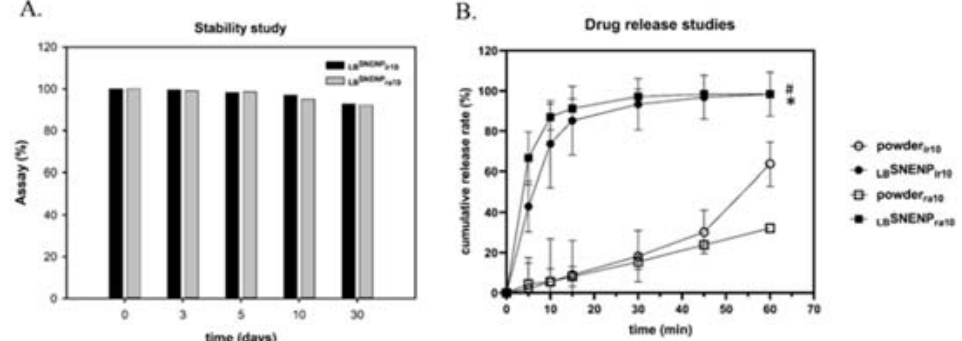
Figure 1. Content of irinotecan or rapamycin-loaded LB SNENP in the stability test ( A ); drug release profiles of the irinotecan powder, rapamycin powder, LB SNENP ir , and LB SNENP ra ( B ). * p < 0.05 when LB SNENP ir was compared with the irinotecan powder. # p < 0.05 when LB SNENP ra was compared with the rapamycin powder. Each point is shown as mean ± standard deviation (n = 3). Abbrevia-